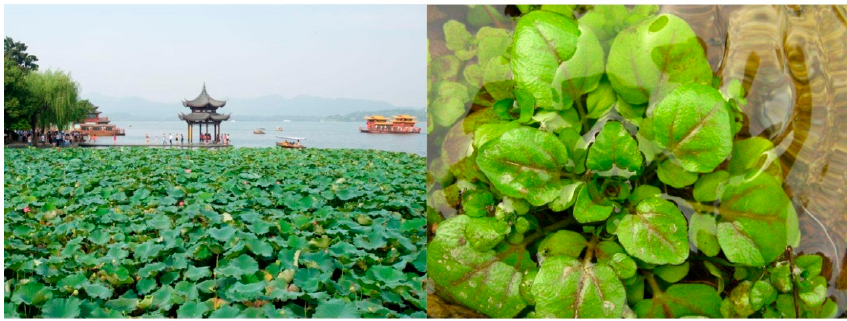
Figure 2. Aquatic plants artificially planted in a shallow lake in China.